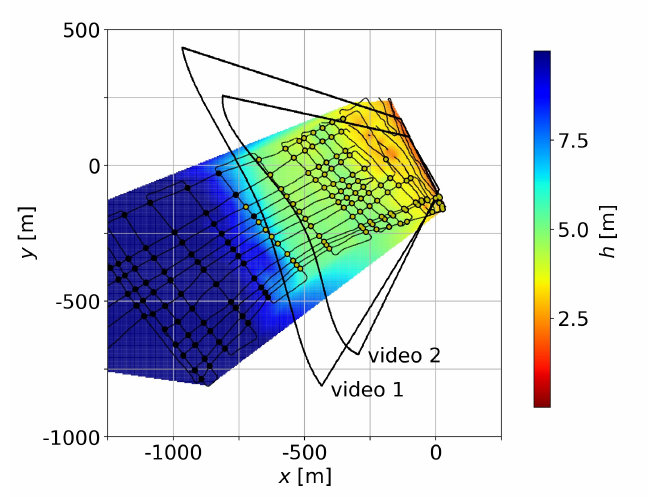
Figure 2. Ground truth bathymetry: path of the echo-sounder. The path intersections for h (cid:54) 7.5 m are highlighted in yellow. The approximate domains for both videos are also included.